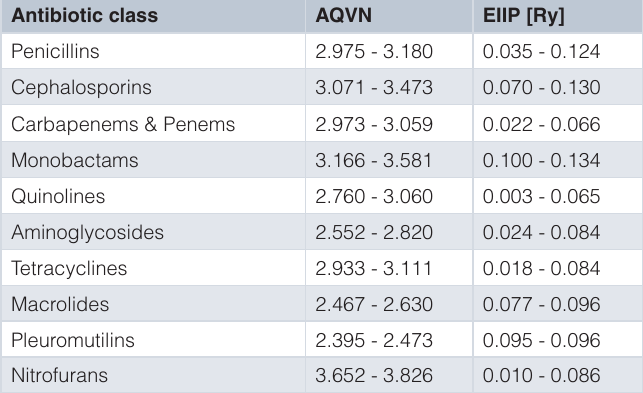
Table 4. AQVN and EIIP range of different antibiotics classes 6 .